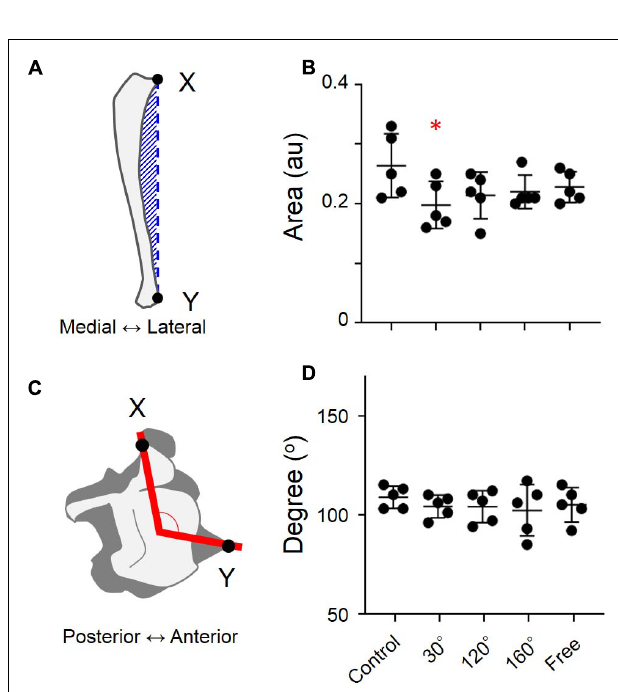
FIGURE 4 | Degree of external curving of tibia and the degree of external rotation of the distal end of tibia in different groups. (A) Methods used to estimate the degree of external curving in tibia, (B) degree of external curving of tibia, (C) degree of external rotation of the distal end of tibia, and (D) degree of external rotation of the distal end of tibia [Mean ± standard deviation (SD) ∗ p < 0.05 vs. the control group, one-way analysis of variance